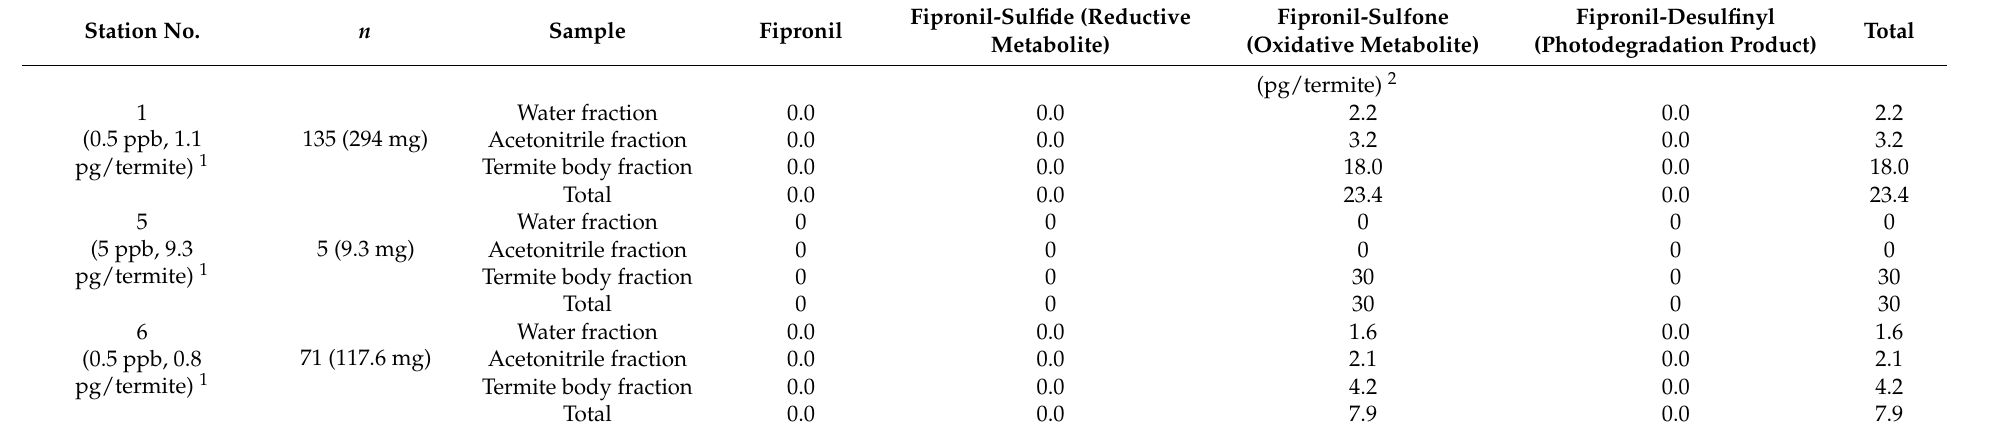
Table 6. Fipronil and its sulfide, sulfone, and desulfinyl derivatives detected from worker caste termites of Reticulitermes speratus collected at Kindai University three weeks after the soil